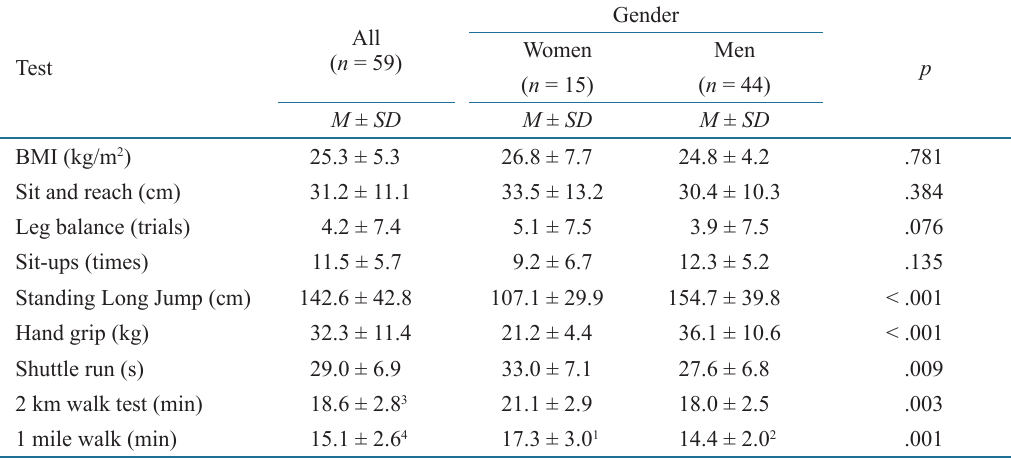
Test performances of Nordic Special Olympics athletes